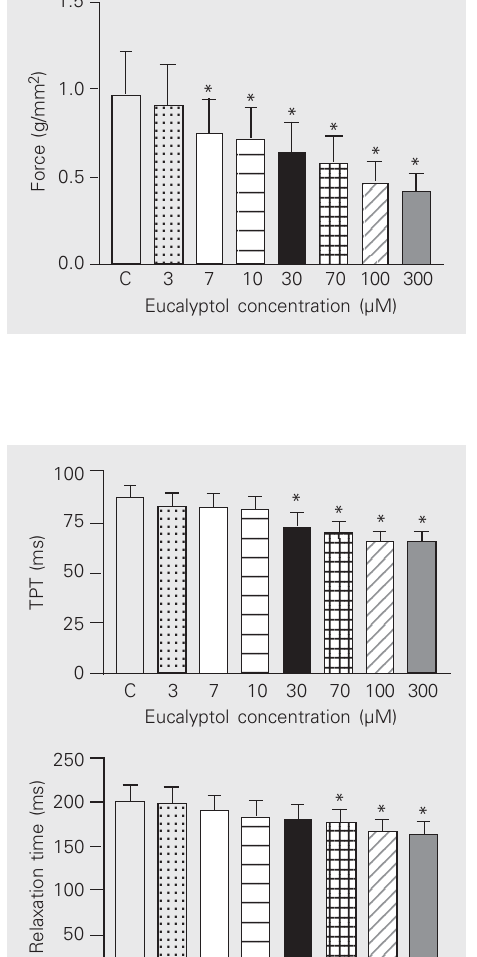
Figure 1. Effect of increasing concentrations of eucalyptol on the isometric force developed by rat papillary muscles. Data are reported as means ± SEM for N = 8. *P < 0.05 for eucalyp- tol vs control (C, one-way ANOVA).